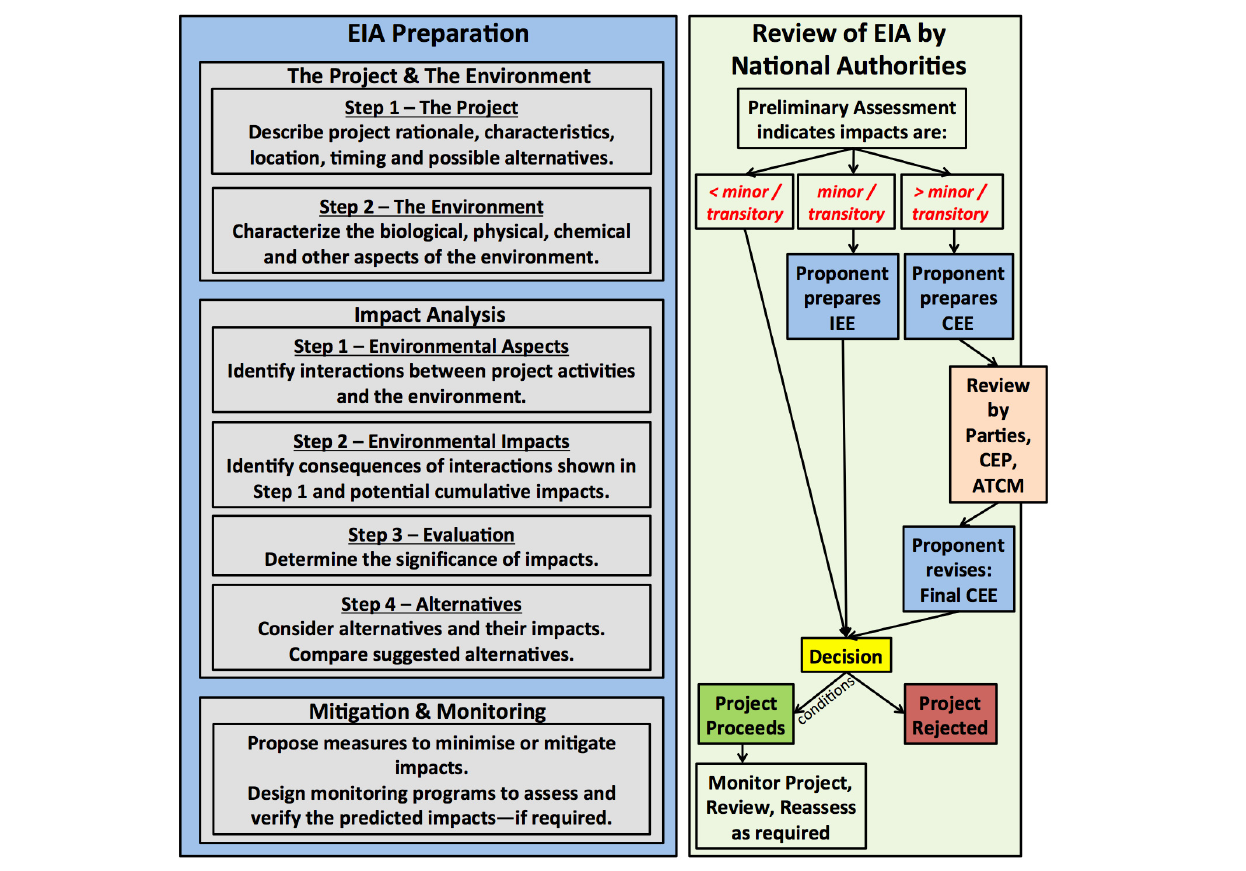
FIGURE 3 | A schematic of the EIA process outlined in Annex I of the Protocol. The Proponent prepares the EIA, which includes sections on the project, the environment, potential impacts, and mitigation and monitoring measures. The EIA is reviewed by national authorities. If impacts are expected to be greater than minor or transitory, the Parties of the Antarctic Treaty, the CEP and ATCM get to review the proposal as well. National authorities make the final decision whether a project goes ahead (potentially with imposed conditions) or